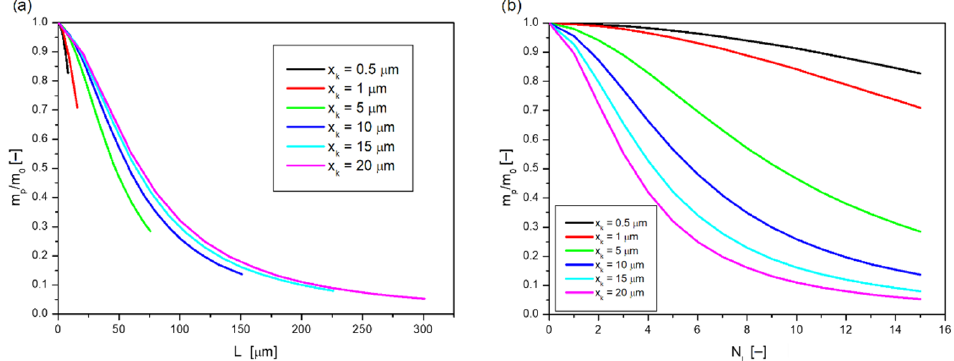
Figure 8. Dependence of dimensionless nanoparticle mass on ( a ) skin layer thickness; ( b ) number of individual cell layers when diffusing through skin structures with different cell sizes (bricks).